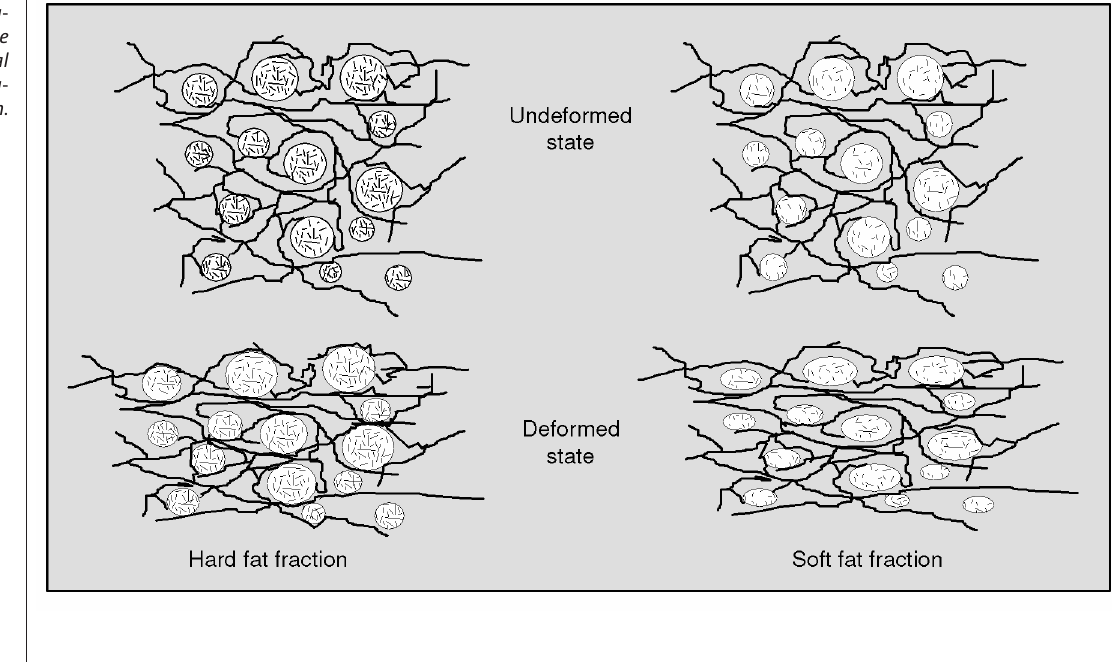
Fig. 6: Schematic presenta- tion of processed cheese and a model for structural changes during deforma-